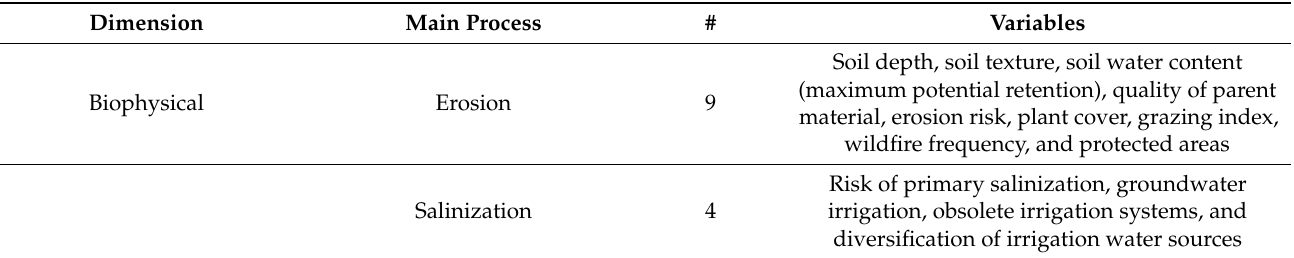
Table 1. List and number of variables used in the empirical approach presented in our study distinguishing the related process of soil degradation and the basic component of change (biophysical or